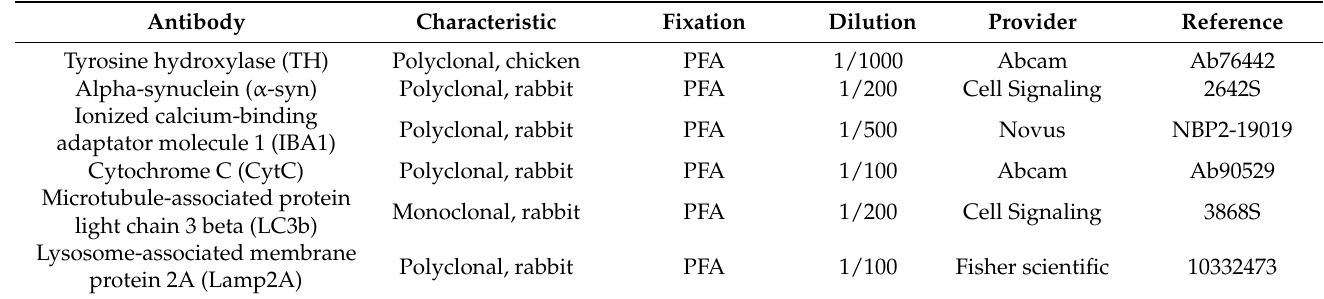
Table 2. List of antibodies used in the present study for